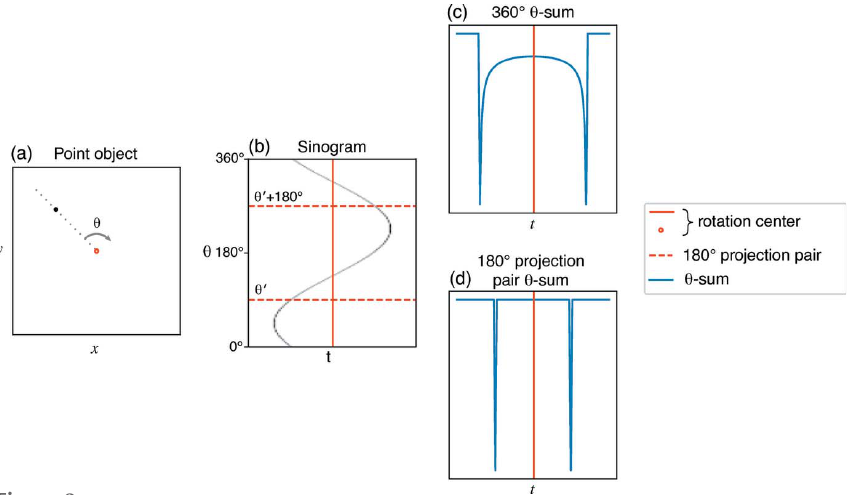
Figure 2 Phase symmetry of a point in motion about an axis of rotation ( a ). A point object gives a simple sinusoid in the sinogram ( b ). The (cid:2) -sum of the full 360 (cid:2) sinogram gives an arcsine distribution symmectric about the rotation axis ( c ). Since any 180 (cid:2) projection pairs sample points on opposite ends of the (cid:2) -sum, they retain the same symmetry ( d ).